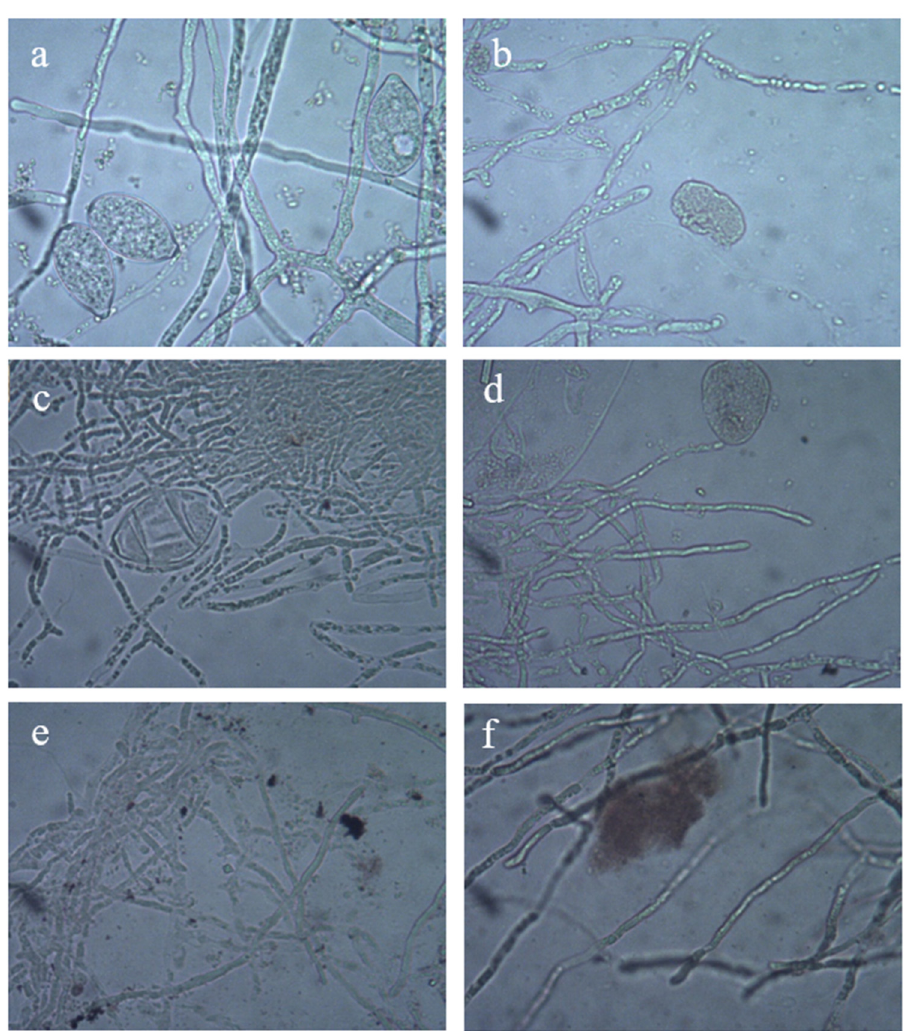
Figure 3. Micrographs of the sporangia of P. litchi . with or without Ag-NP solution. ( a ) Control; ( b ) 50 μ g/mL; ( c ) 100 μ g/mL; ( d ) 200 μ g/mL; ( e ) 400 μ g/mL; and ( f ) 800 μ g/mL. ( b ) 50 µ g/mL; ( c ) 100 µ g/mL; ( d ) 200 µ g/mL; ( e ) 400 µ g/mL; and ( f ) 800 µ